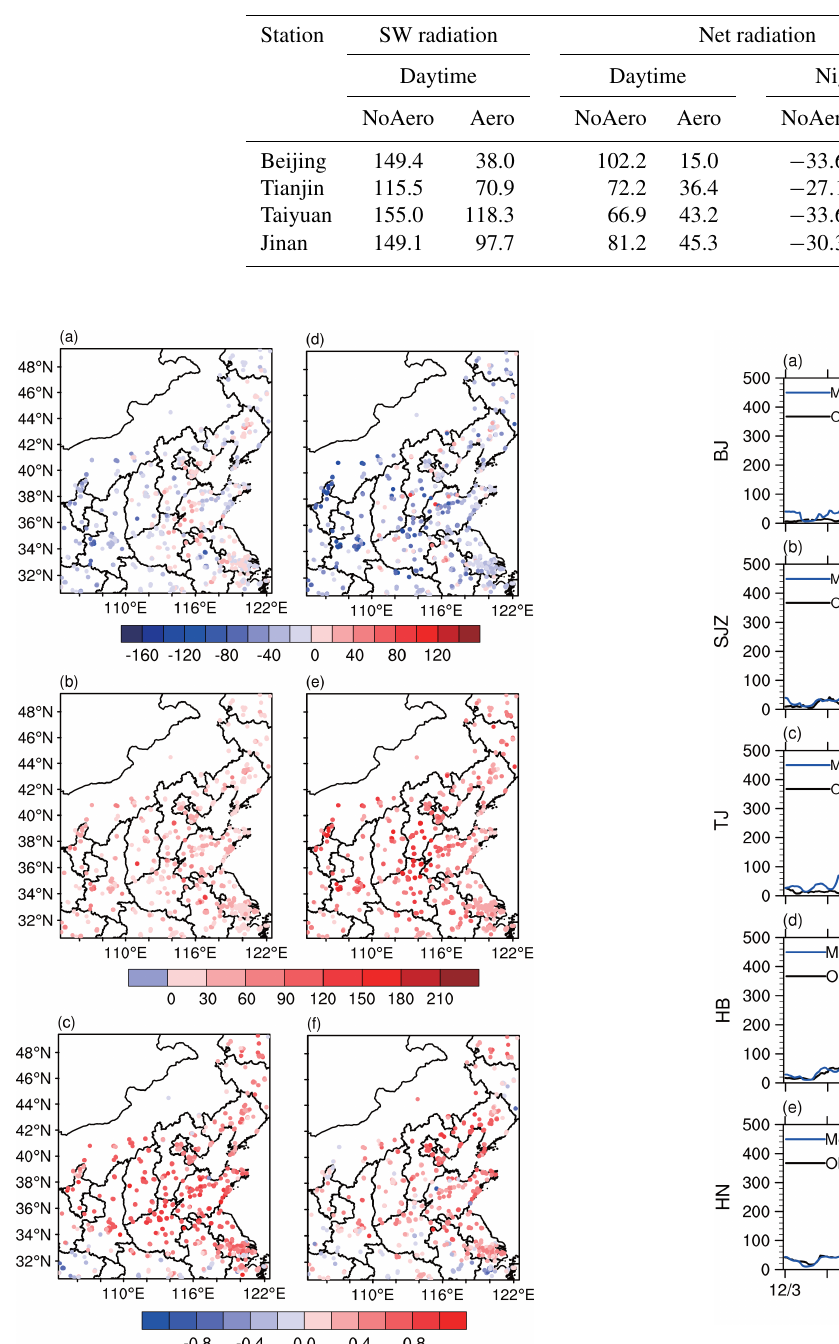
Figure 7. Observed (black) and WRF-Chem simulated (blue) tem- poral variation of PM 2 . 5 (µgm − 3 ) at three major cities, (a) Bei- jing (BJ), (b) Shijiazhuang (SJZ) and (c) Tianjin (TJ), and two provinces, (d) Hebei (HB) and (e) Henan